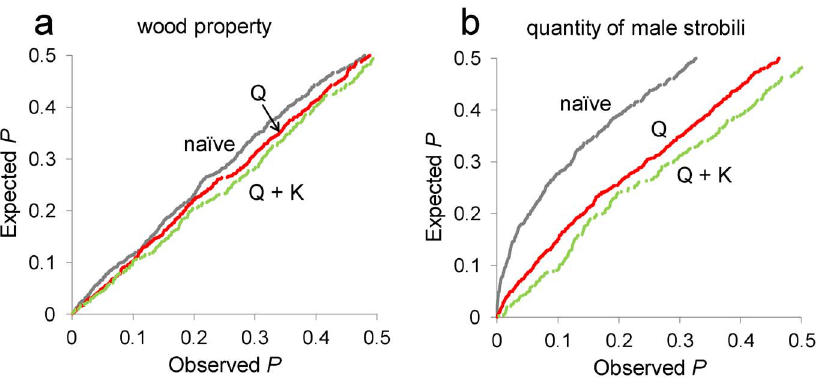
Figure 4. Comparison of models applied to C.japonica quantitative traits. Evaluation of the model type I error rates using random SNPs for wood property (a), quantity of male strobili (b). The cumulative distributions of observed P- values are presented for the naı¨ve model, the Q model and the Q + K model.